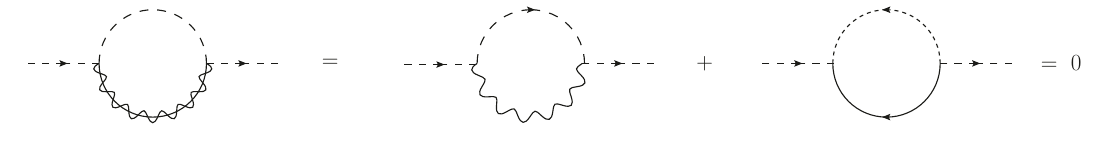
Figure 5 . The one-loop correction to hypermultiplet propagator